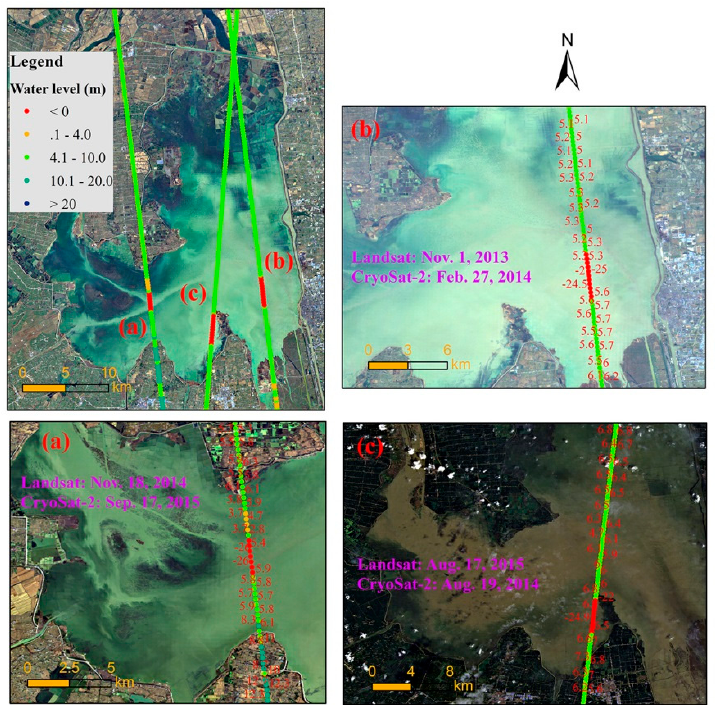
Figure 3. Outliers in the center of Gaoyou Lake. Note: the base map was obtained from Landsat OLI images. The red dots represent outliers.